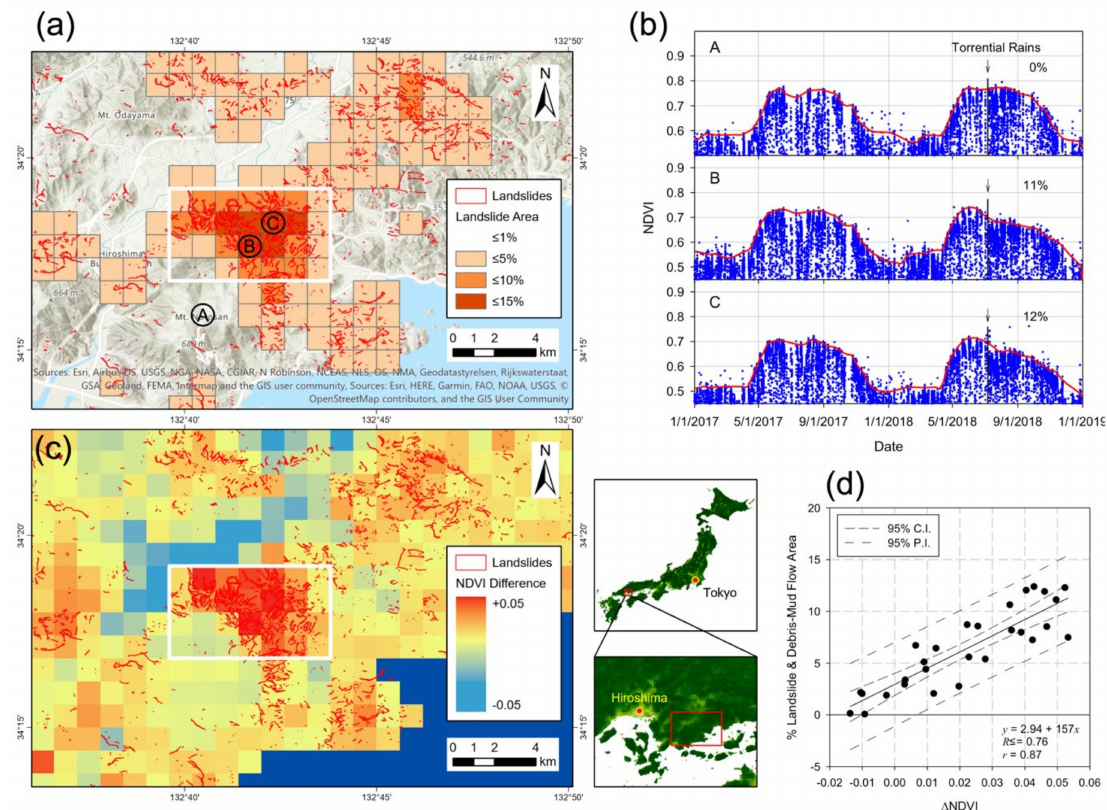
Figure 13. Summary of AHI NDVI landslide detection analysis for a torrential rain event in Hiroshima, Japan in the summer of 2018. The location of the analysis area is indicated on the two frames at the bottom center. ( a ) Percent landslide areas (including debris-mud flow areas) derived from the landslide- and debris-mud flow polygon dataset (shown as “Landslides” on the map) [47]. The circled letters (A, B, and C) correspond to the locations where AHI NDVI temporal signatures in ( b ) were extracted. The white line box represents the region used for the correlative analysis in ( d ). ( b ) AHI NDVI temporal profiles of landslide- and debris-mud flow-a ff ected pixels. The filled squares are AHI NDVI values whereas the red lines are the smoothed NDVI profiles (see Appendix A). ( c ) ∆ NDVI (pre-event NDVI minus post-event NDVI). Five day local means centered on 18 June 2018 and 5 August 2018 were used as pre-event and post-event NDVI values, respectively. ( d ) Percent landslide and debris-mud flow area vs. ∆ NDVI crossplot. The C.I. and P.I. are, respectively, the confidence and prediction intervals. The maps were created with ArcGIS ® software (ArcGIS ® Pro 2.4.1, Esri, Redlands, CA, USA, http: //